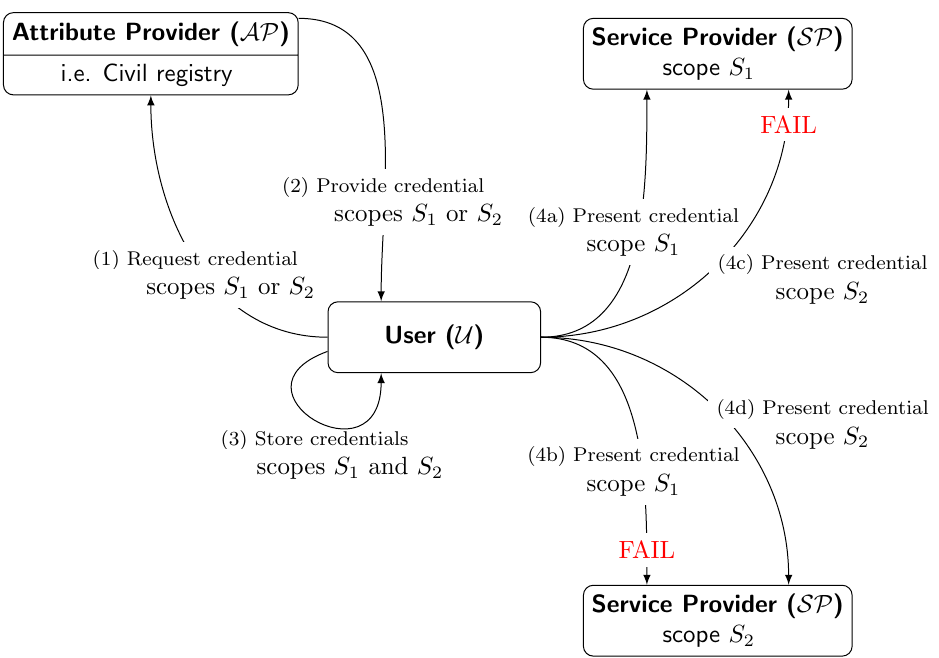
begins the protocol by request- U provides the user with a credential. AP stores both credentials. ( 4 ) presents U U presents the credential for S 1 to SP of U presents the credential for S 1 to U presents credential for S 2 to SP U presents credential for S 2 to SP of U